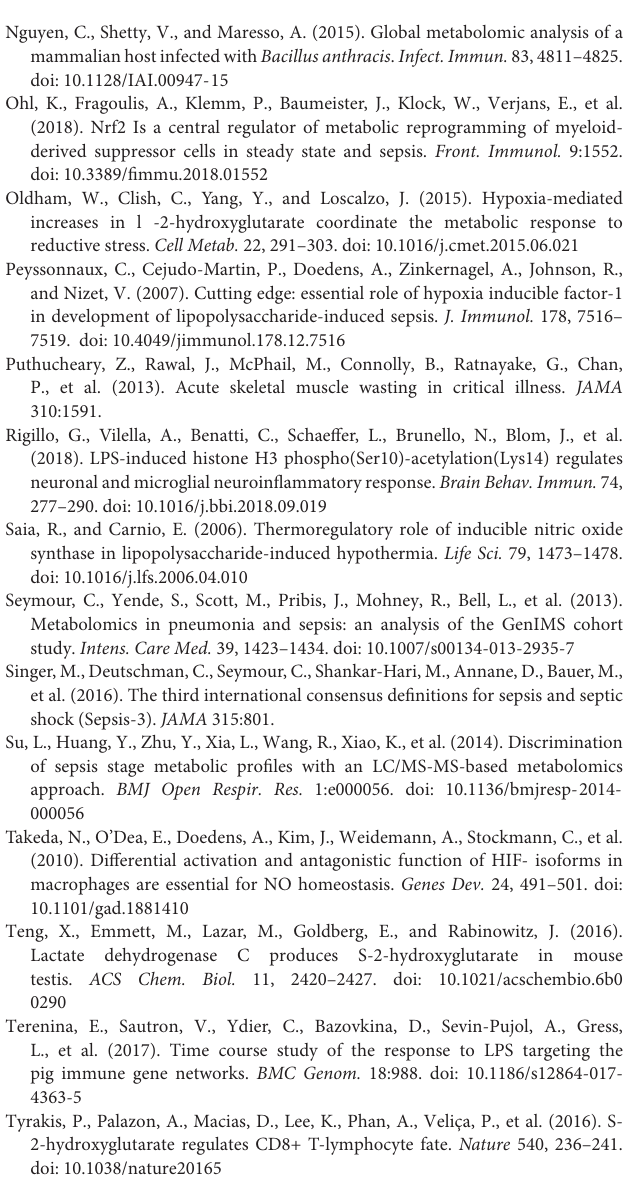
FIGURE S3 | Following radiotelemetry implantation baseline measurements were obtained for systolic and diastolic blood pressure, and heart rate. Mice were subsequently treated with LPS (15 mg/kg) or a combination of LPS and S-2HG (50 ug/kg) and recordings were obtained for an additional 8 h. N =